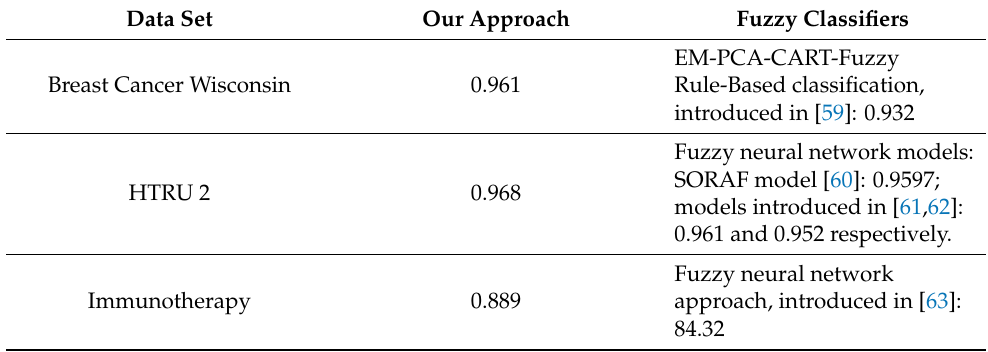
Classification accuracy comparison with fuzzy classification techniques for chosen data sets is shown in Table 8 as well.